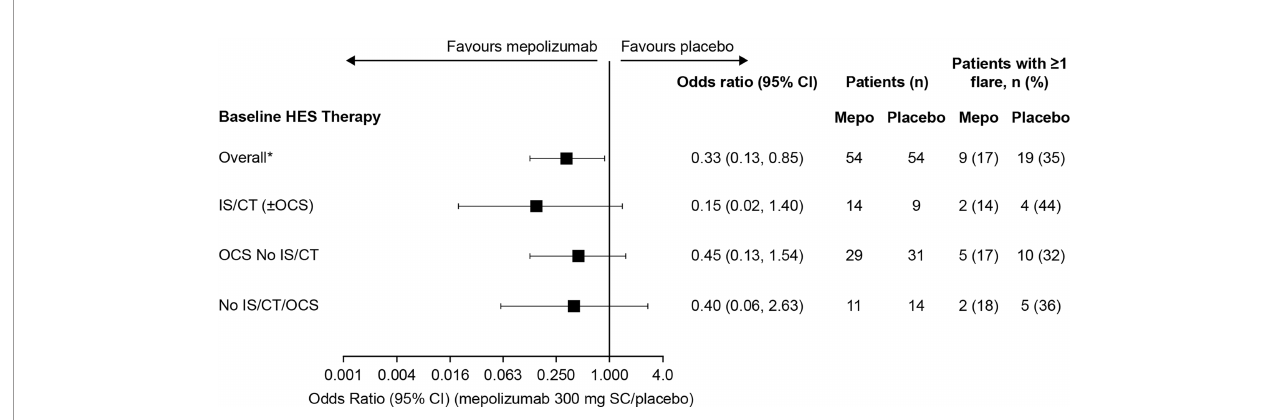
FIGURE 4 | Odds of a patient experiencing ≥ 1 fl are with mepolizumab versus placebo during Week 20 though Week 32 by baseline treatment type. *These values were originally reported in Roufosse et al., 2020. CI, con fi dence interval; CT, cytotoxic therapy; HES, hypereosinophilic syndrome; IS, immunosuppressive therapy; OCS, oral corticosteroid; SC,